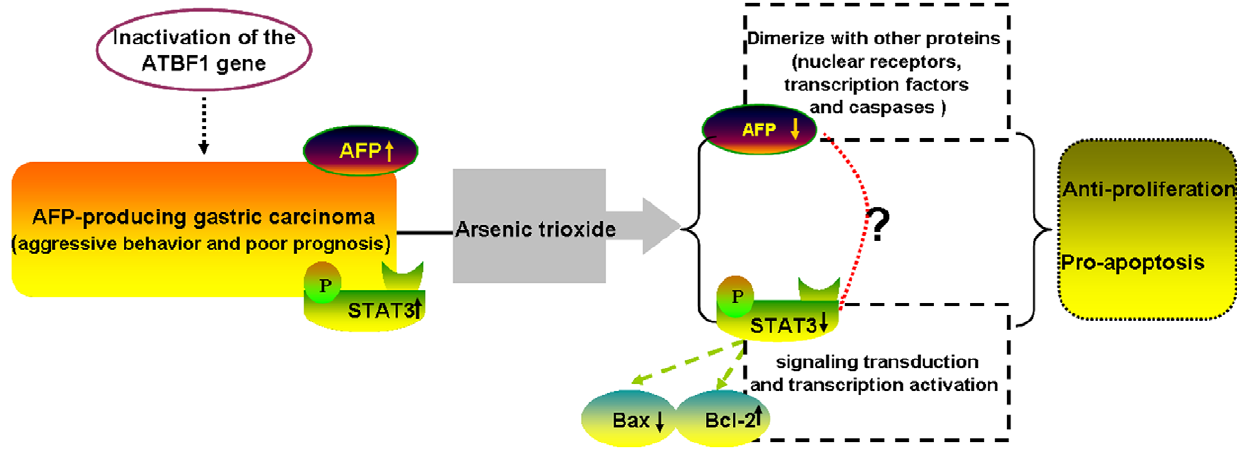
Figure 7. Schematic illustration of As2O3-induced growth inhibition and apoptosis of FU97 cells. Inactivation of the ATBF1 gene in AFPGC, through mutation or reduced expression, may allow AFPGC cells to produce AFP protein and overexpress STAT3, which contributes to aggressive behavior and poor prognosis of AFPGC. As2O3 can inhibit AFPGC cell growth and induce cell apoptosis. The underlying mechanisms may involve downregulation of AFP and STAT3 expression and STAT3 downregulating the expression of anti-apoptotic Bcl-2 and upregulating that of the tumor suppressor Bax. Furthermore, AFP can dimerize with other proteins such as nuclear receptors, transcription factors and caspases, all of which can promote growth of tumor cells. AFP may dimerize with the transcription factor STAT3 to promote AFPGC growth. Therefore, AFP may interact with STAT3 in the signal pathway for chemotherapeutic efficiency of agents on AFPGC.